Question: According to this chart, does the measure grow or shrink?
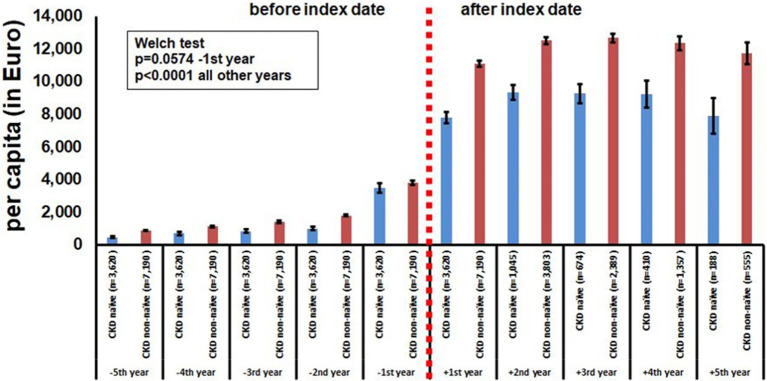
Answer: decreasing